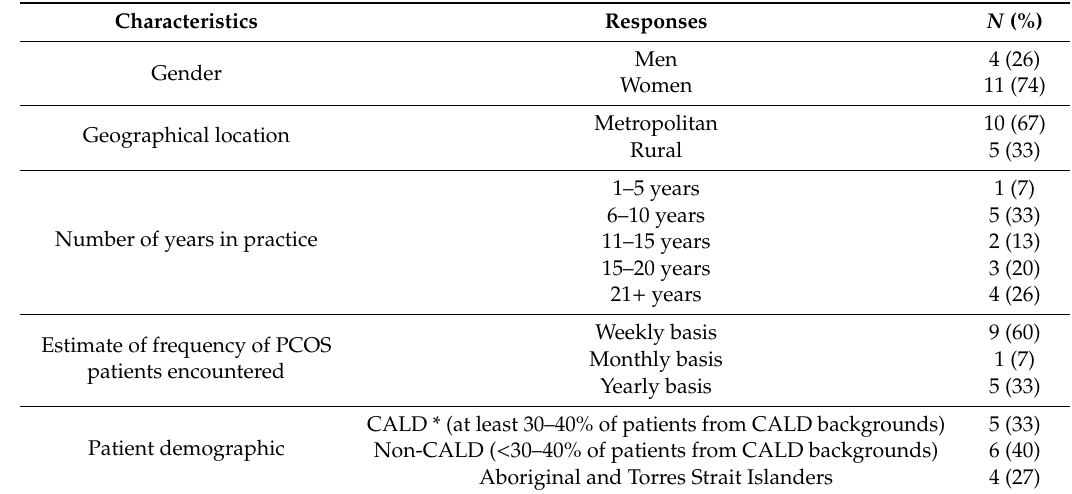
Table 1. Baseline characteristics of participants.